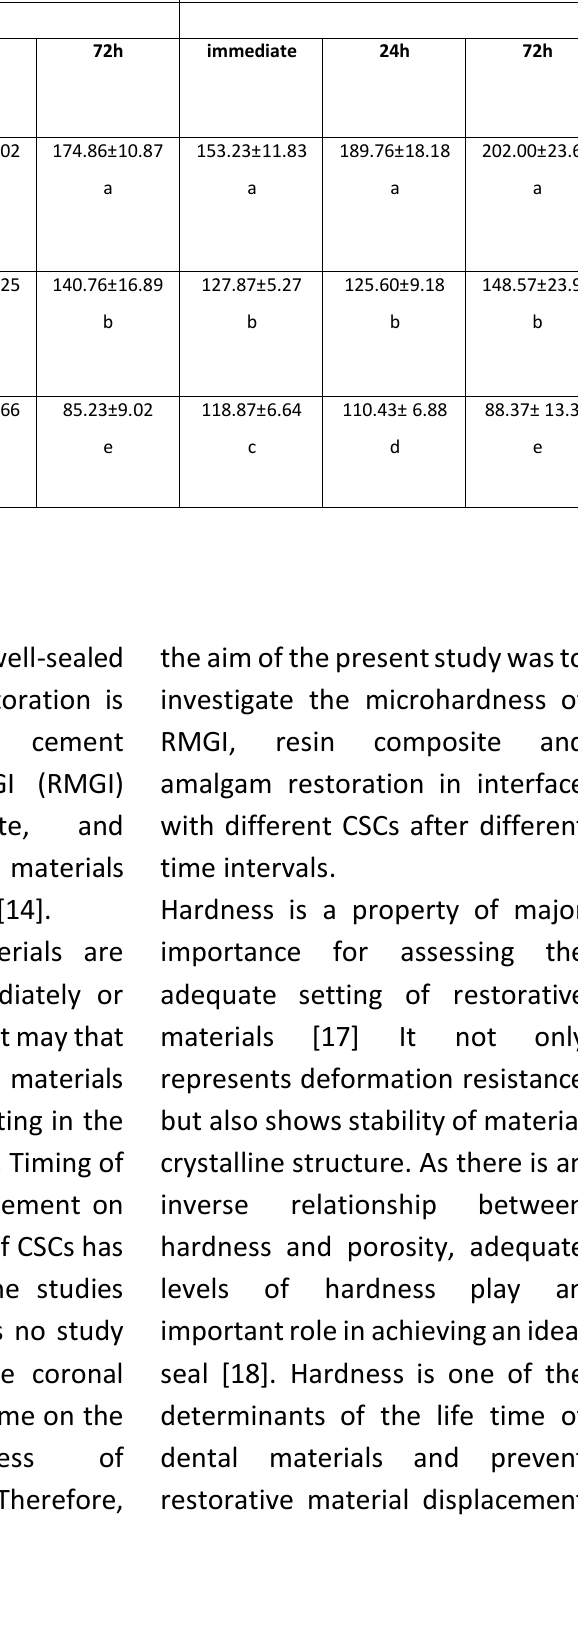
Table 2 – Mean±SD of the microhardness of different restorative materials in contact with CSCs in different times: Biodentin Cem cement